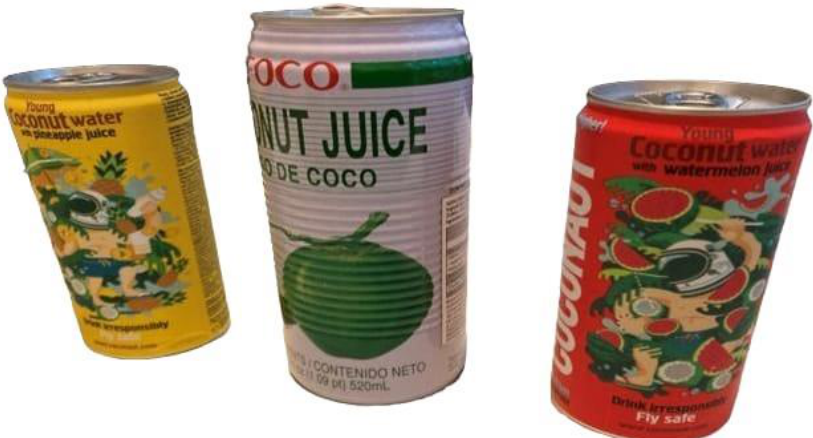
Figure 1. Coconut sap as beverages, bought from a local ethnic shop in Rovaniemi, Finland. (Photo credit: © Dele Raheem, July 2022).